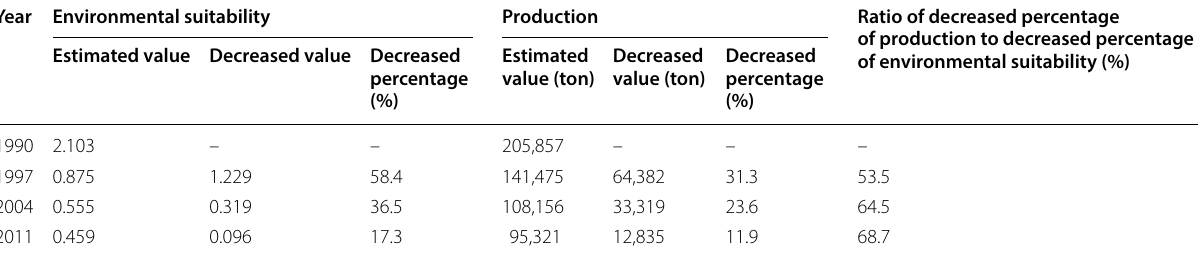
Table 2 Environmental suitability and production for seaweed in Japan estimated using the production-environmental suitability